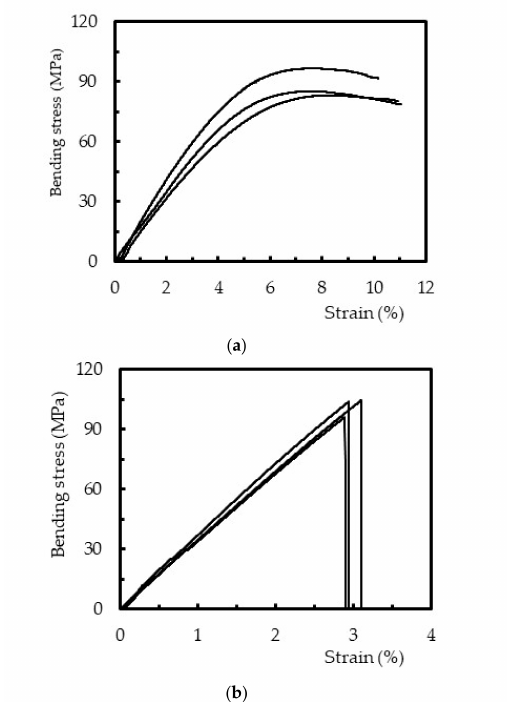
Figure 6. Flexural stress versus strain for: ( a ) post-cure at 40 ◦ C for 12 h (specimen 4) and ( b ) post-cure at 60 ◦ C for 6 h (specimen